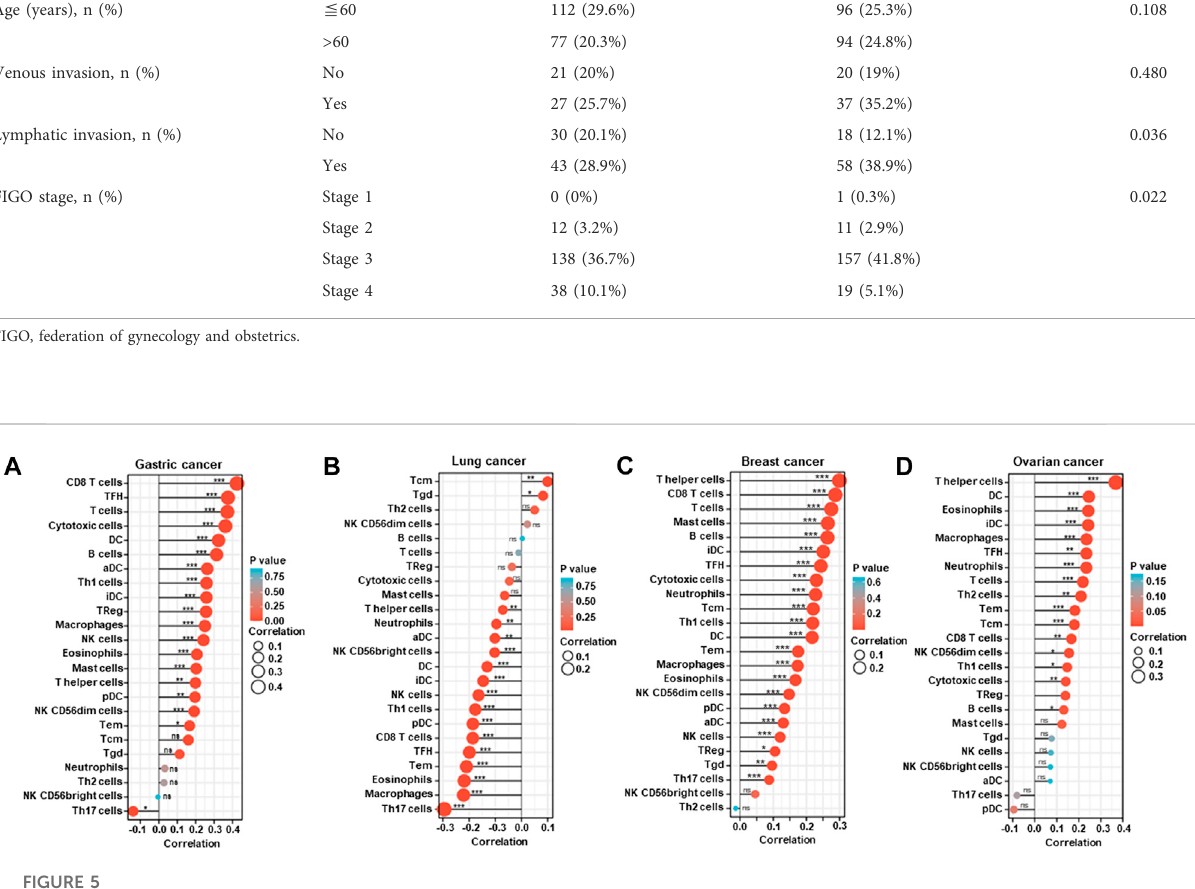
FIGURE 5 The relationship between BTG1 mRNA expression and immune in fi ltration in cancers. The enrichment of immune cells was explored between lowandhighexpressionof BTG1 ingastric (A) ,lung (B) ,breast (C) ,andovarian (D) cancersusingxiantao.ns,notsigni fi cant;*p < 0.05;**p < 0.01;***p <